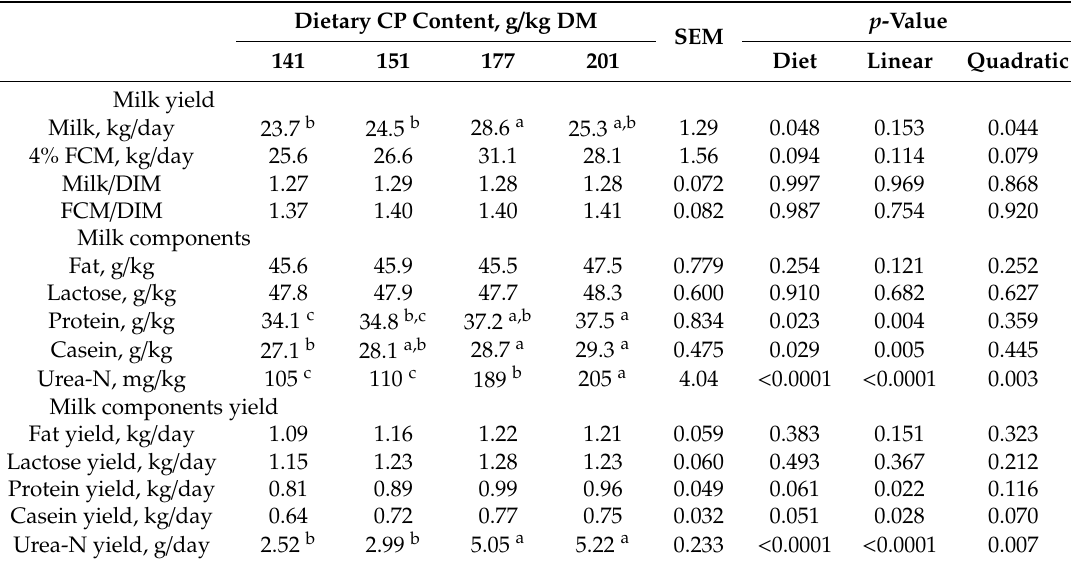
Table 4. E ff ect of dietary CP level on milk yield, components, and milk components yield. Dietary CP Content, g / kg DM